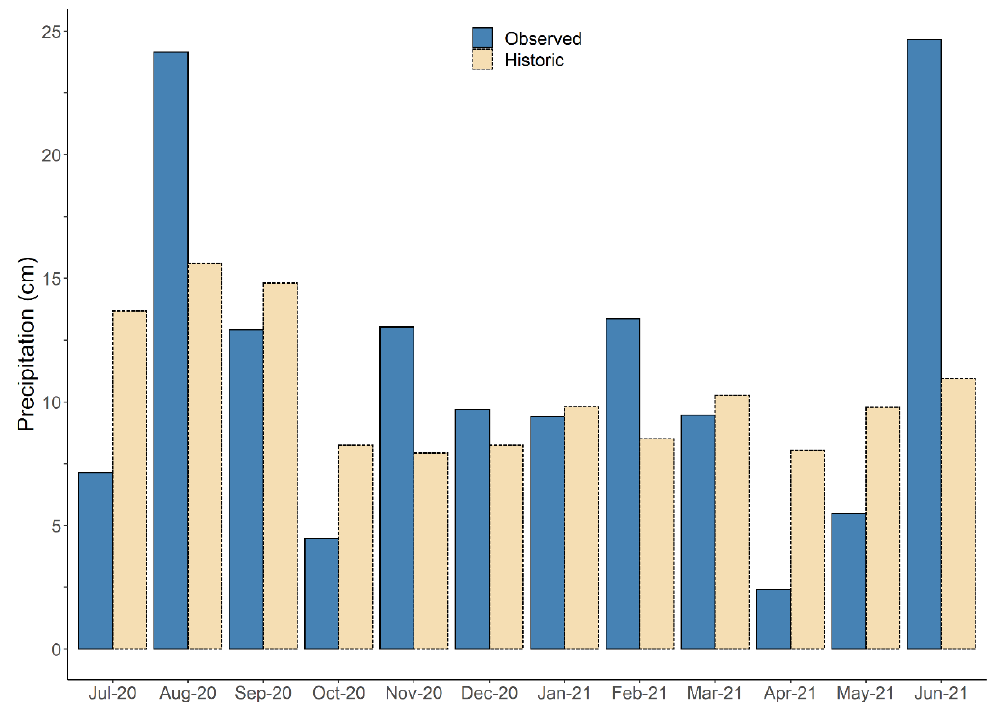
Figure 3. Average and observed monthly rainfall for Greenville, NC between the months of July 2020 and June 2021. Rainfall during the study was similar to the long-term historic mean, with 5 months exceeding the mean average and 7 months below the mean average. Overall, there was 8% more rainfall during the study than the long-term mean.